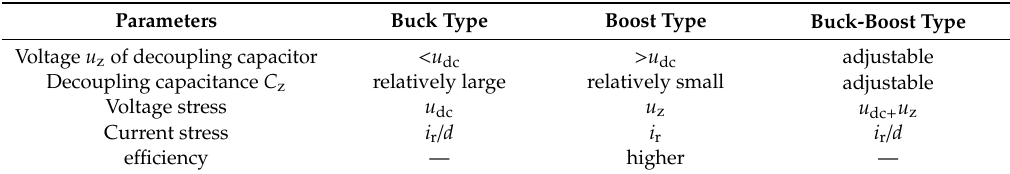
Table 1. Comparison of three